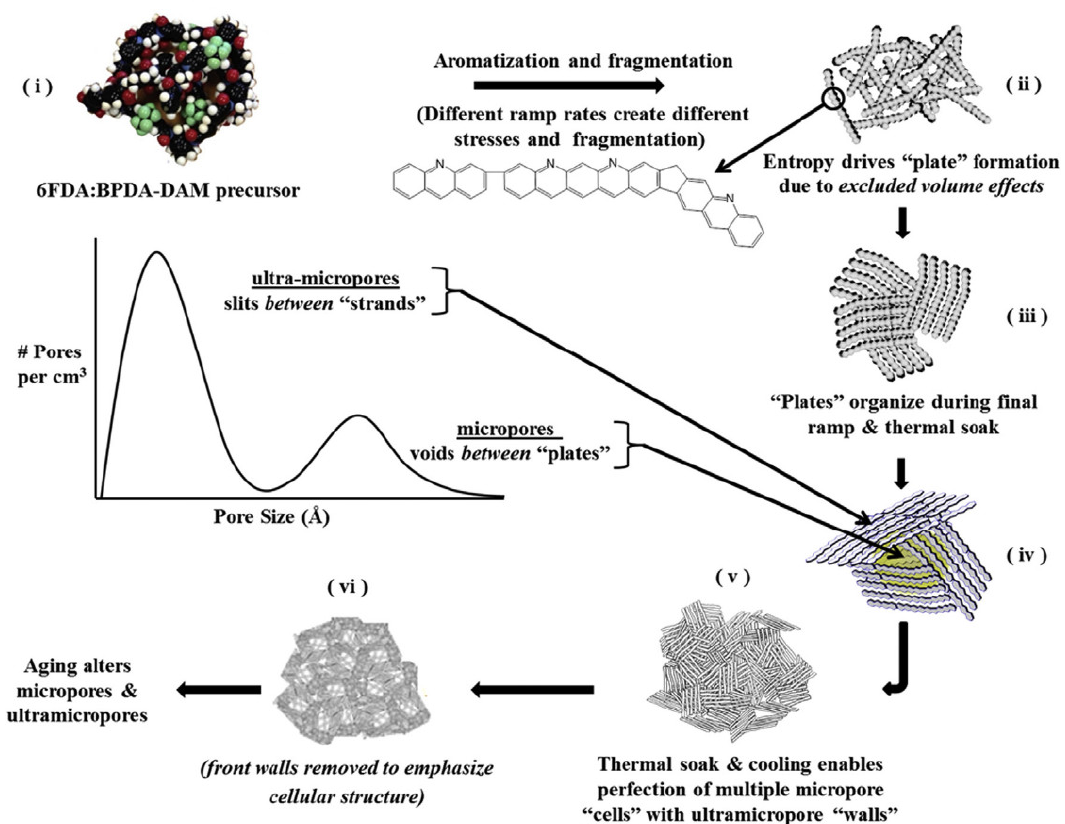
Figure 5. Illustration of the transformation steps of polyimide precursor to amorphous CMS material with micropores and ultramicropores. Adapted from Ref. [85] with permission. Copyright (2017) Elsevier.